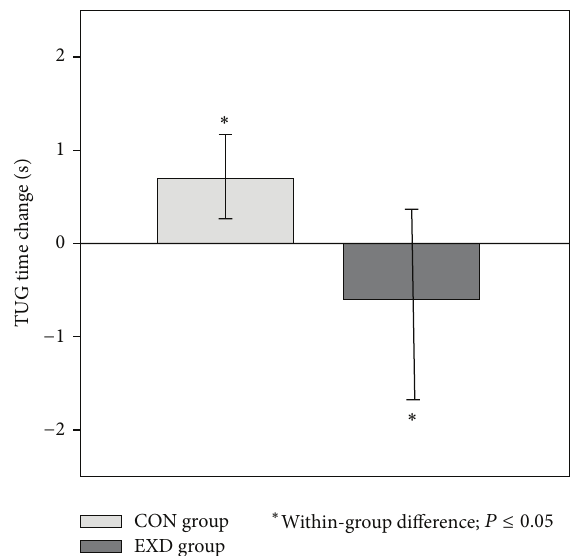
Figure 2: Changes in the EXD and CON groups in TUG time change with the 12-week intervention. The EXD group improved TUG time by of 0.6 (2.1)sec with the 12-week intervention ( 𝑃 = 0.04 ) and the CON group saw a decline of 0.7 (SD = 0.9 ) after the 12 weeks ( 𝑃 = 0.05 ). ∗ Significant changes within groups ( 𝑃 < 0.05 ). TUG: timed up and go. All data were analyzed using analysis of covariance adjusted for baseline values. All data are expressed as least squared means (standard error).